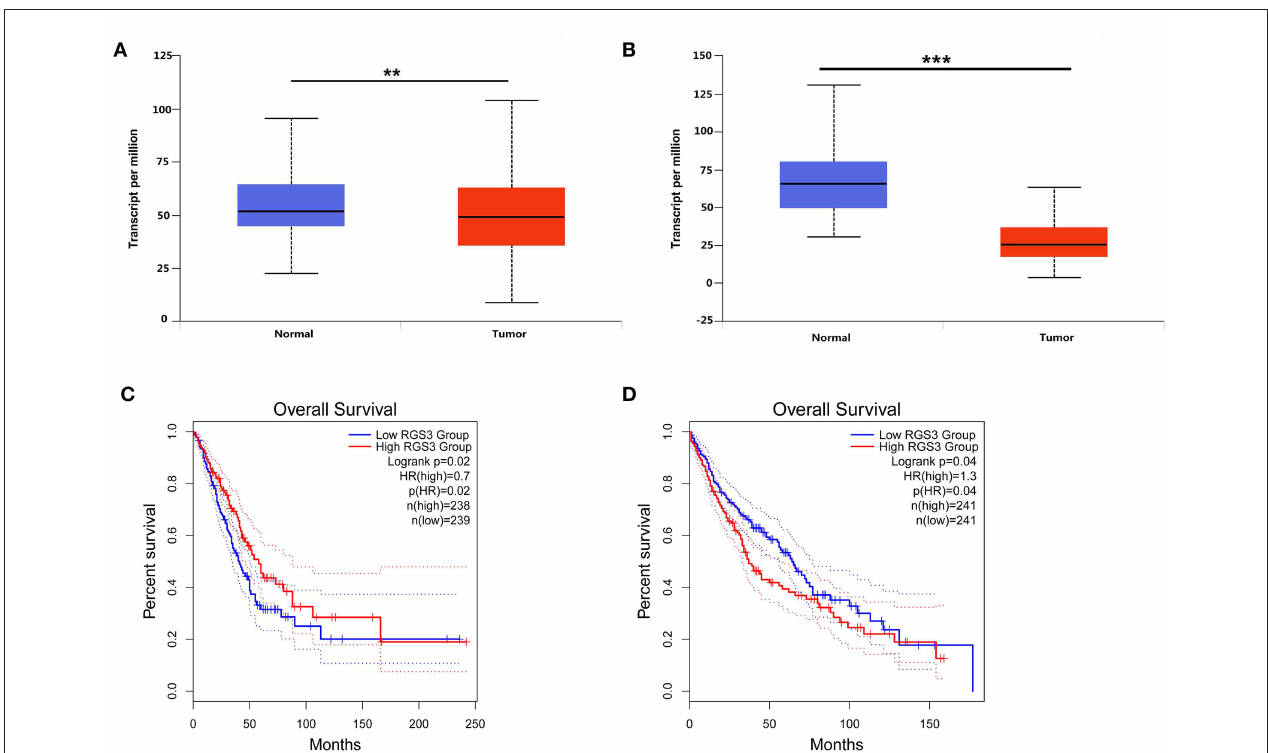
FIGURE 6 | Expression level of RGS3 and its prognostic role in NSCLC. (A,B) Expression of RGS3 was downregulated in lung adenocarcinoma and lung squamous cell carcinoma, values are expressed as Transcript per million, ** p < 0.01, *** p < 0.001, t -test; (C,D) The association between expression of RGS3 and the risk of lung adenocarcinoma (C) and lung squamous cell carcinoma (D) . HR, hazard